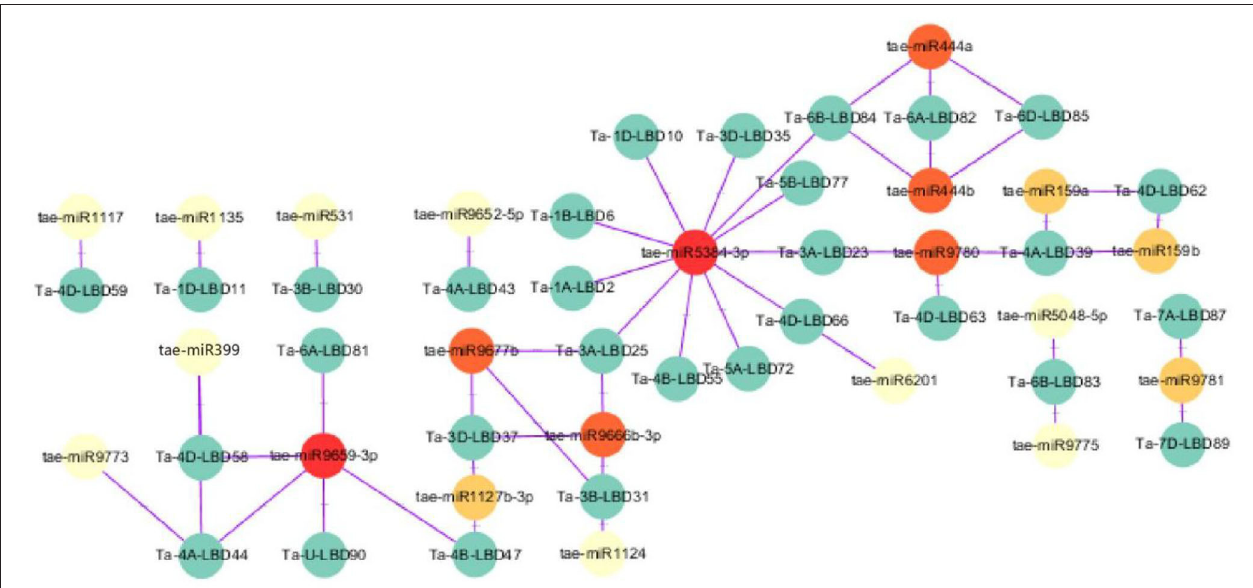
FIGURE 4 | A schematic representation of the regulatory network relationships between the putative miRNAs and their targeted TaLBDs. The miRNAs that regulate one TaLBD are shown in yellow circles, miRNAs that regulate two TaLBDs are shown in orange circles, and miRNAs that regulate more than two TaLBDs are shown in red circles. The miRNAs and TaLBDs linked by the purple line indicate a putative regulatory relationship. TaLBDs, wheat lateral organ boundaries domain